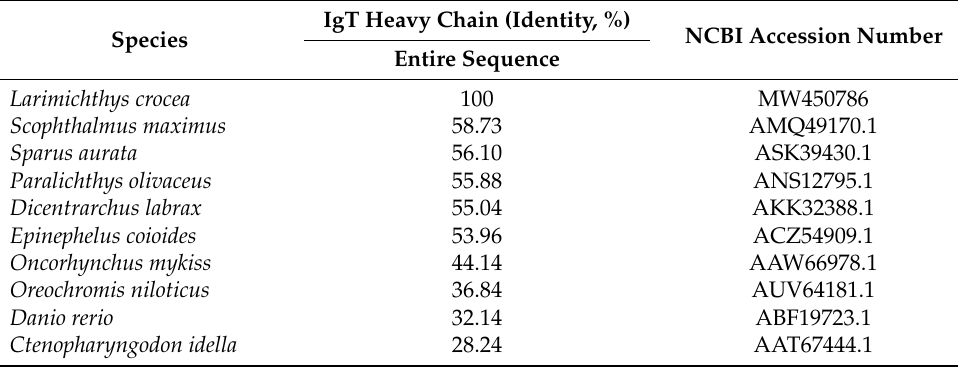
Table 1. The IgT heavy chain protein sequences used for phylogenetic analysis.